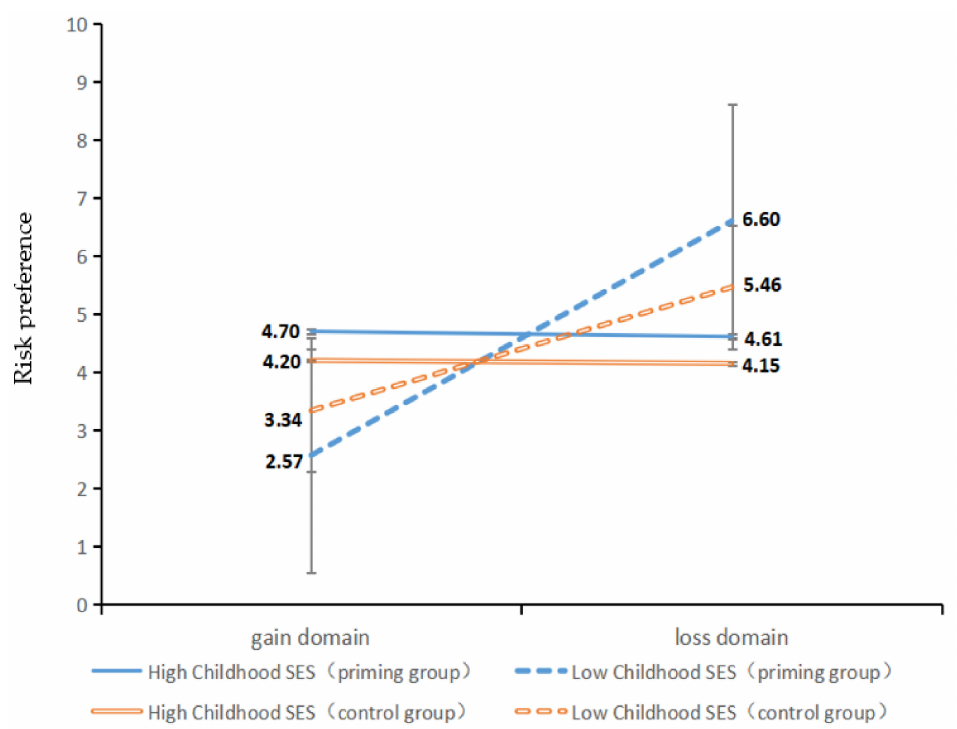
Figure 2. The effect of childhood SES on adolescents’ risk behaviors in the gain and loss domains under physiological threat